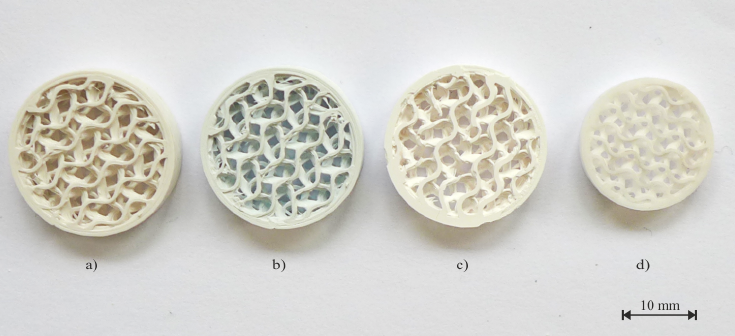
Figure 10. Part with an internal gyroid structure: ( a ) Printing on FFF technology, ( b ) Chemical debinding, ( c ) Thermal debinding, ( d ) Sintering